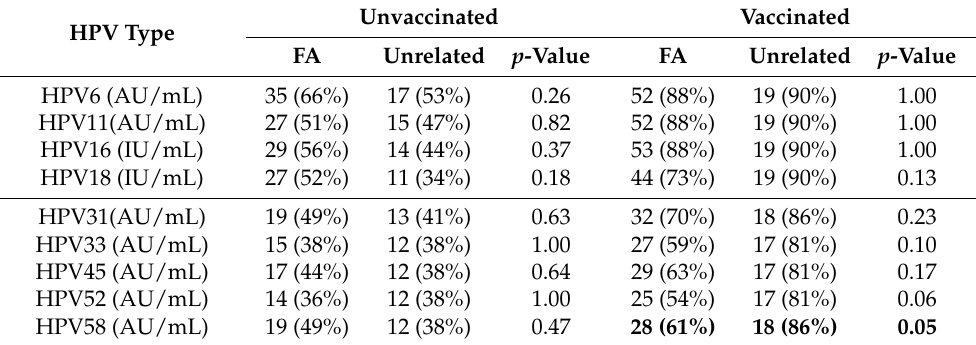
Table 6. Seropositivity in Participants with FA Compared to Unrelated